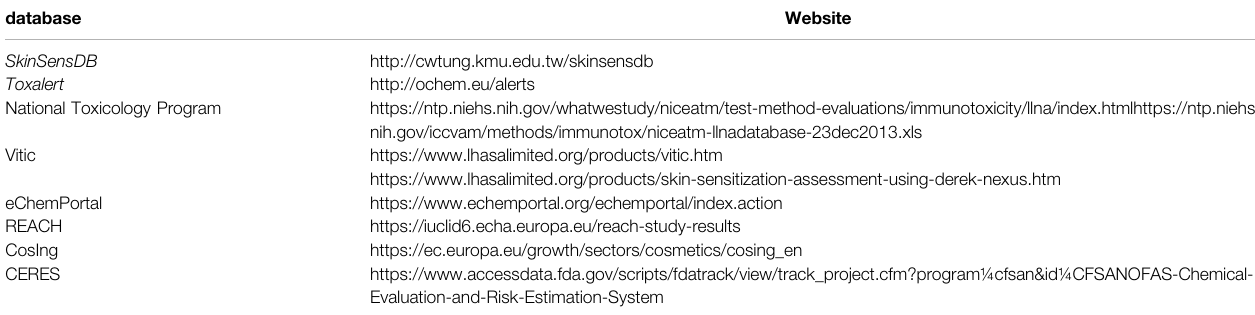
TABLE 6 | Online skin sensitization